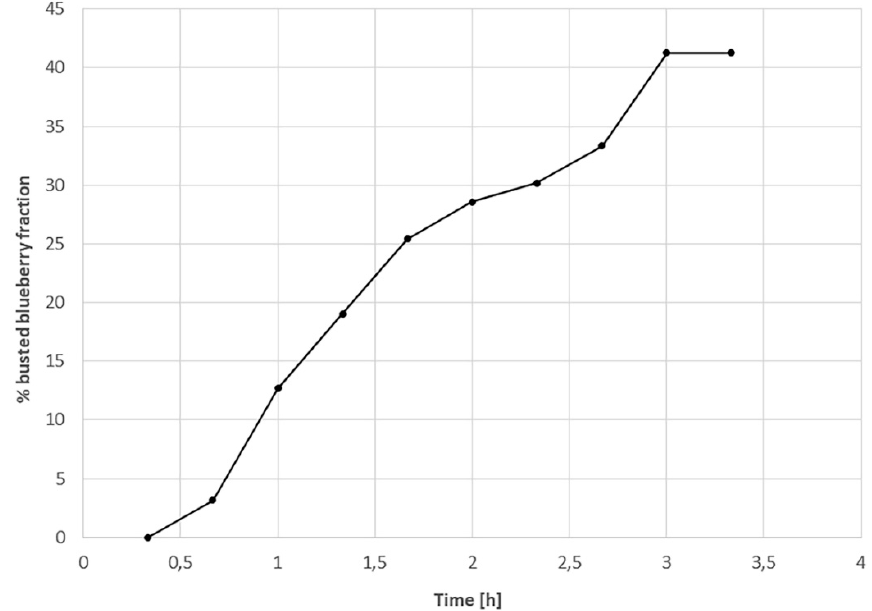
Figure 3. Visual evaluation of the busting process. Inspection of photographs taken at different times during the freeze-drying of whole nontreated blueberries.